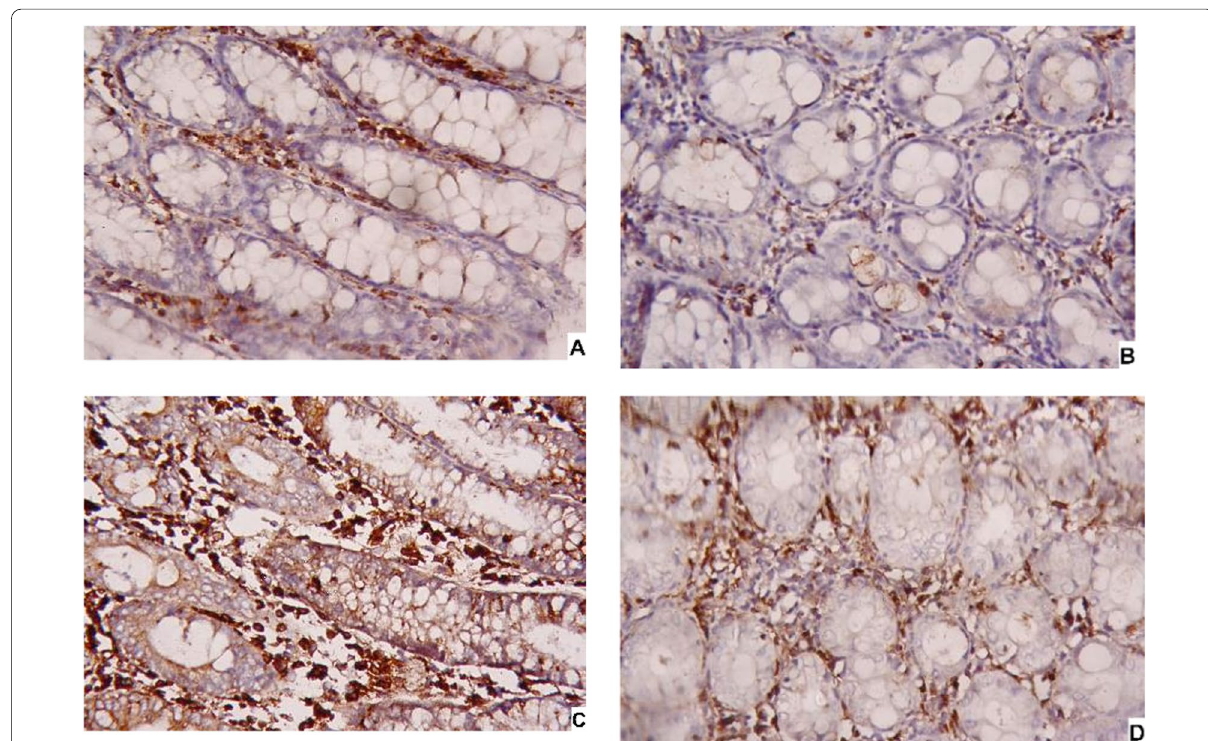
Fig. 4 Photomicrographs of colon specimens of different groups immunostained with Caspase-3 ( showed normal moderate nuclear Caspase-3 IHC positivity. B DMH group showing weak cytoplasmic Caspase-3 IHC positivity. C 5FU treated rat showed a severe Caspase-3 immunoreaction in mucosal glands. D Ferulic acid and 5-fluorouracil treated rat showing moderate Caspase-3 IHC